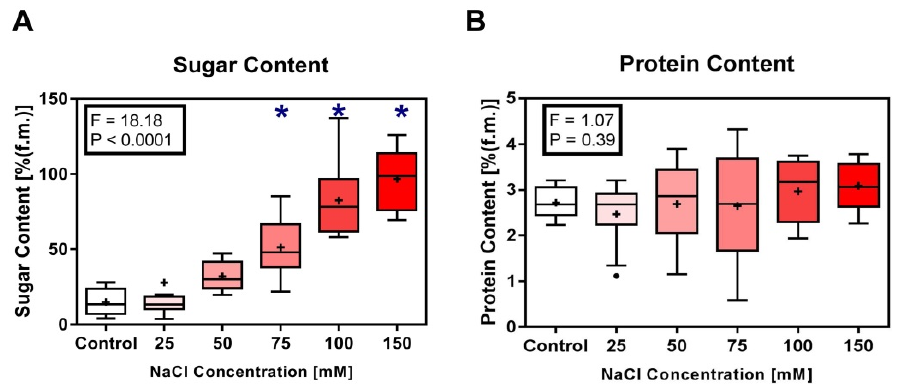
Figure 4. Side-by-side boxplots of changes in biochemical parameters in Solanum melongena . ( A ) sugar content, ( B ) protein content in response to each of five NaCl concentrations. p -values at α = 0.05. * indicates values significantly different from the control (Dunnett’s test with p < 0.05).